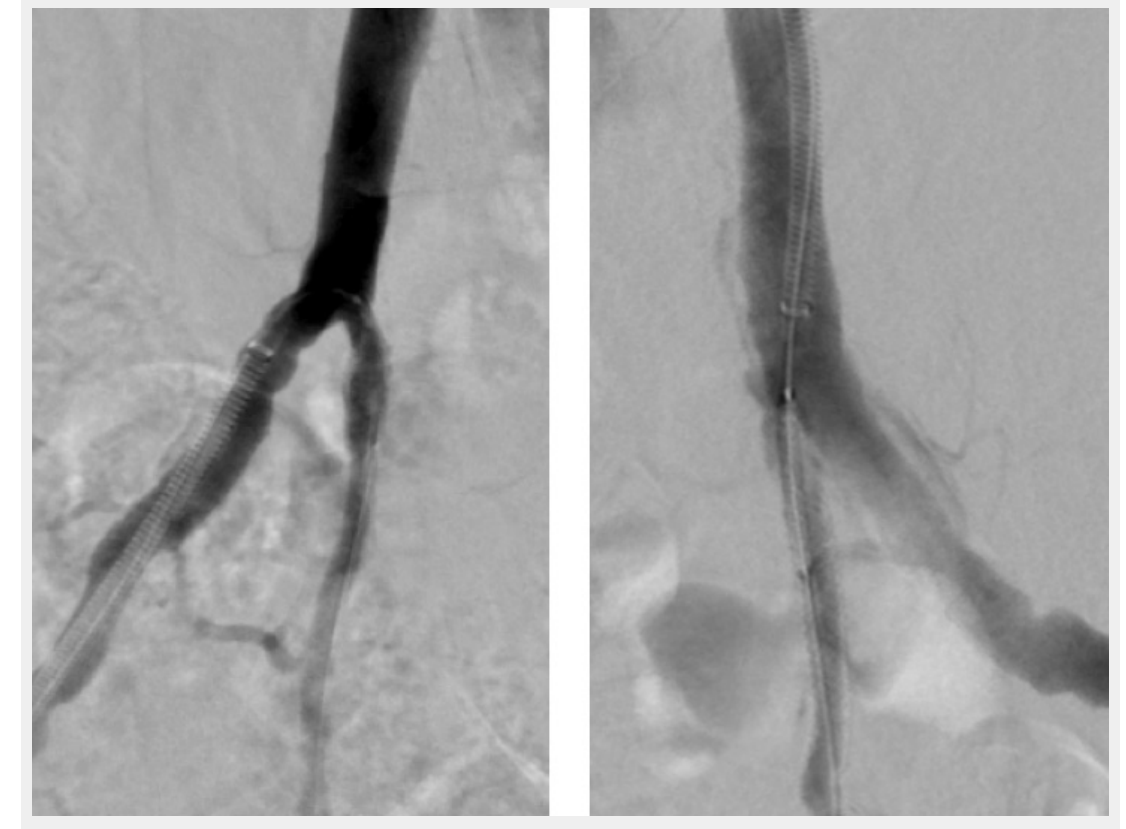
Figure 4 Angiographic result after bilateral placement of drug eluting